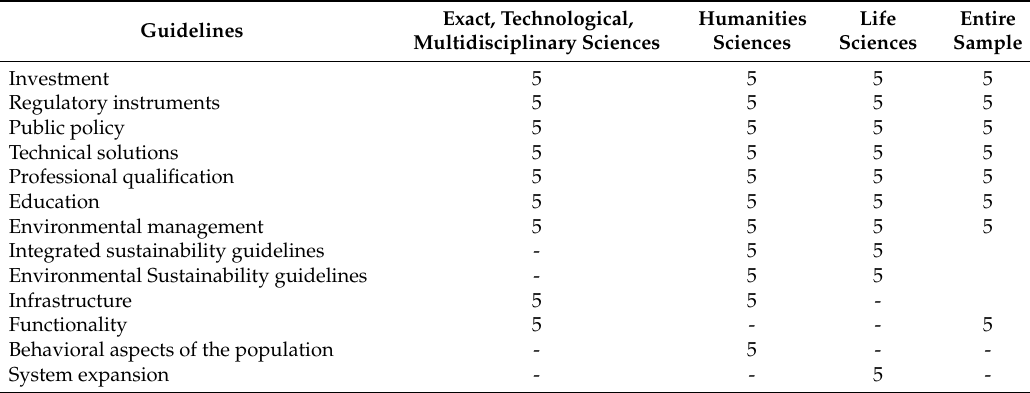
Table 2. Drivers ranked as “extremely important” by professionals who participated in the survey.